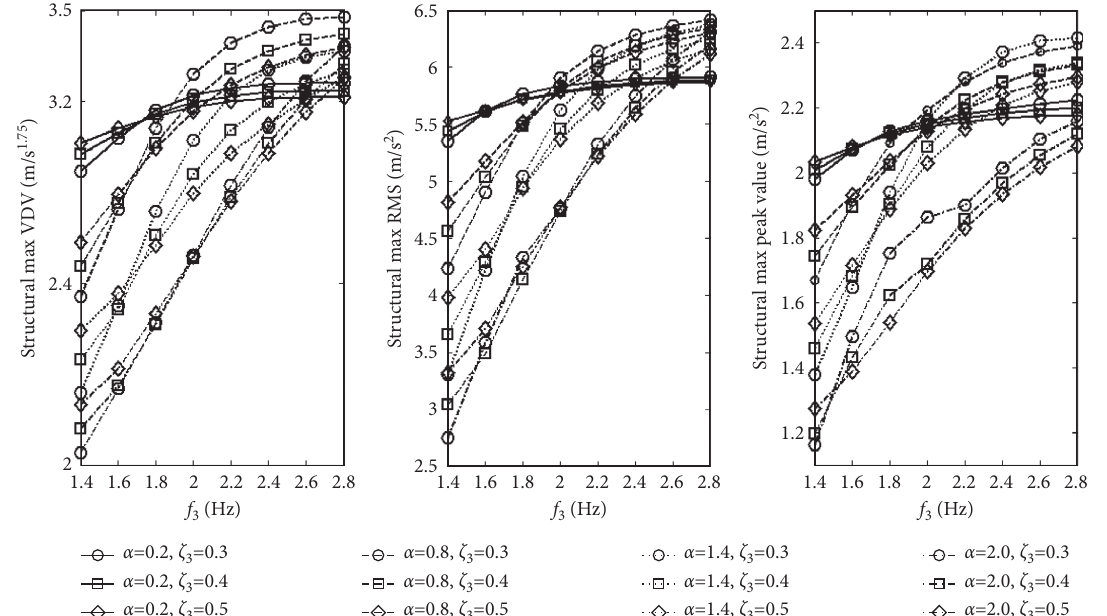
Figure 19: The influence of passive crowd parameters on structural dynamic responses of max acceleration VDV, RMS, and peak values.